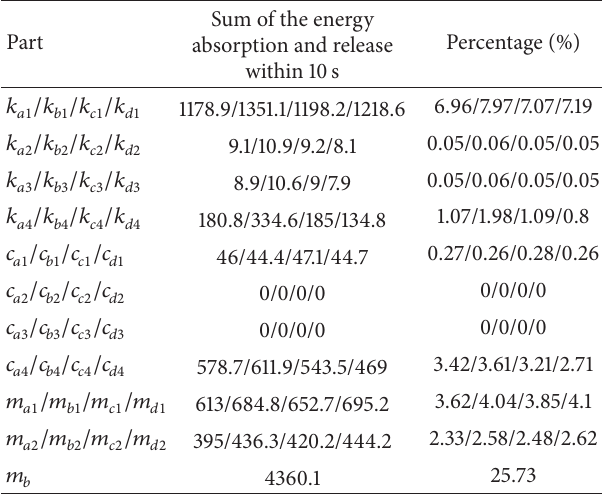
Table 2: Sum of the energy absorption and release of each part in the system within